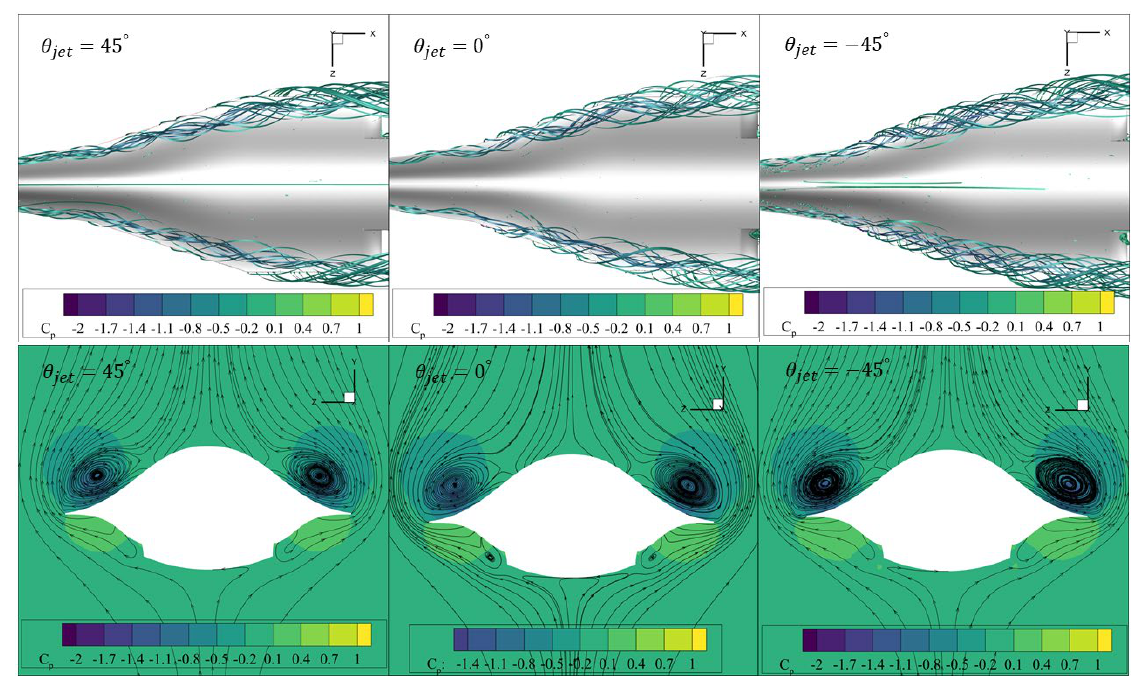
Figure 24. Comparison of the streamlines for different blowing directions at α = 10 ◦ , x / L 0 = 0.6.